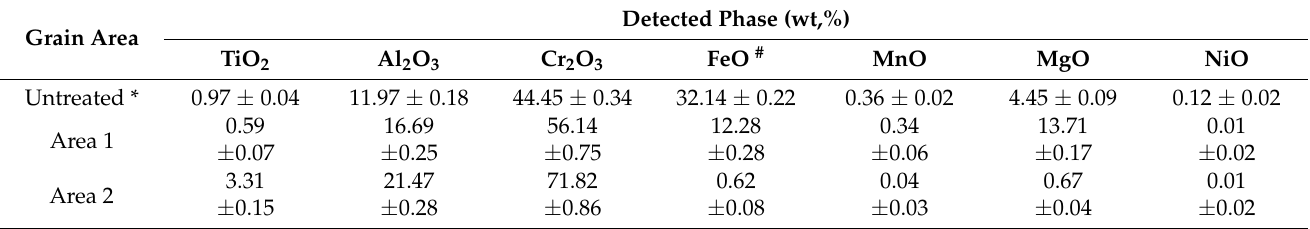
Table 5. EPMA of particle Areas 1 and 2 (as indicated in Figure 4) of ore particles reduced by hydrogen at 1100 ◦ C for 30 min. Table 5 presents 90 spot analyses from Area 1 (center) and 21 spot analyses from Area 2 (transition phase).